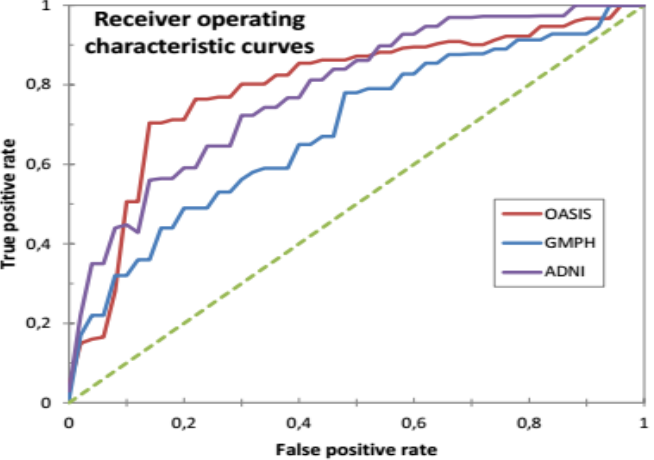
Figure 14. ROC curves for classification of AD vs. HC with SVDD (RBF function with σ = 0.5) for MRI /PET images from ADNI, OASIS and GMPH databases. Table 2. Performance results of support vector data description (SVDD) classifier in terms of accuracy (AC)%, sensitivity(SE)% and specificity (SP)% using 10-fold cross-validation and grid search to perform ( σ , C ) hyper-parameter optimization of SVDD.